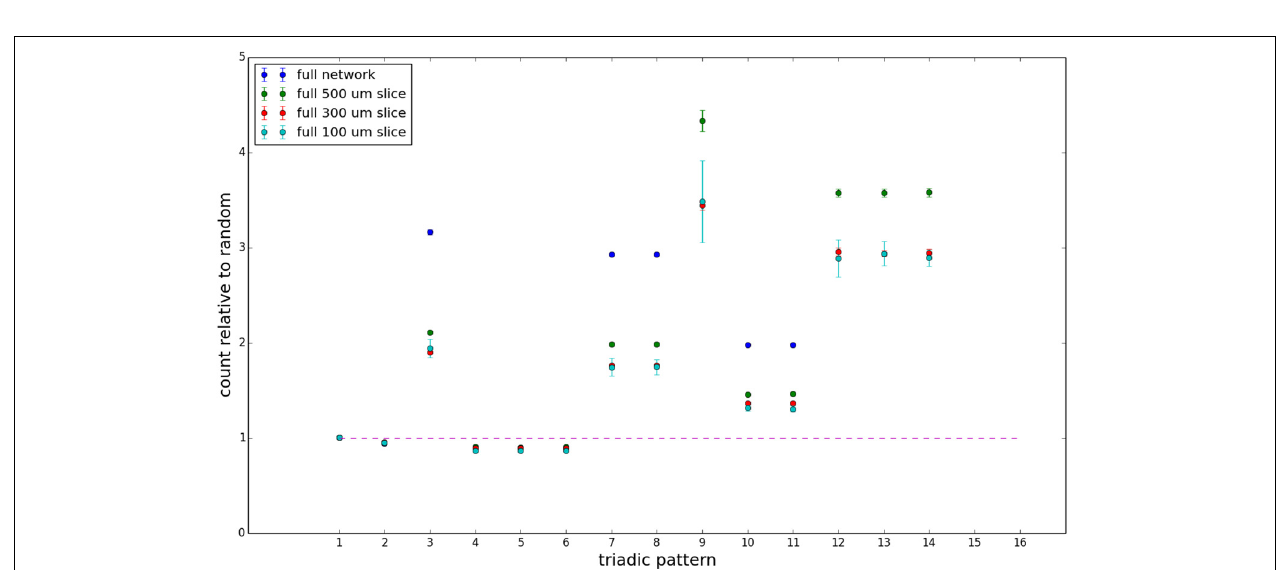
FIGURE 8 | Triadic motif counts for complete sections (full sampling). Error bars indicate standard error of the mean. Average over five populations.